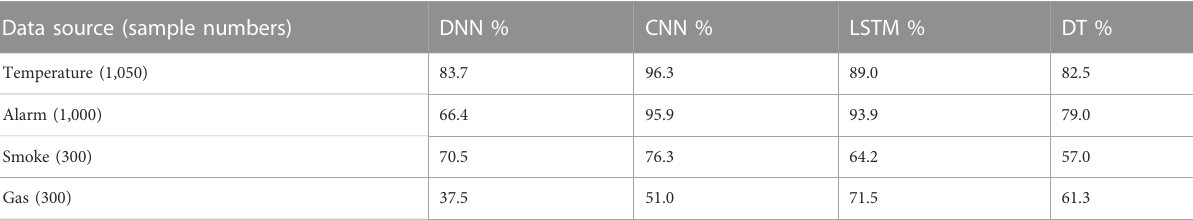
TABLE 3 Prediction accuracy results of the machine leaning model sensitivity analysis.